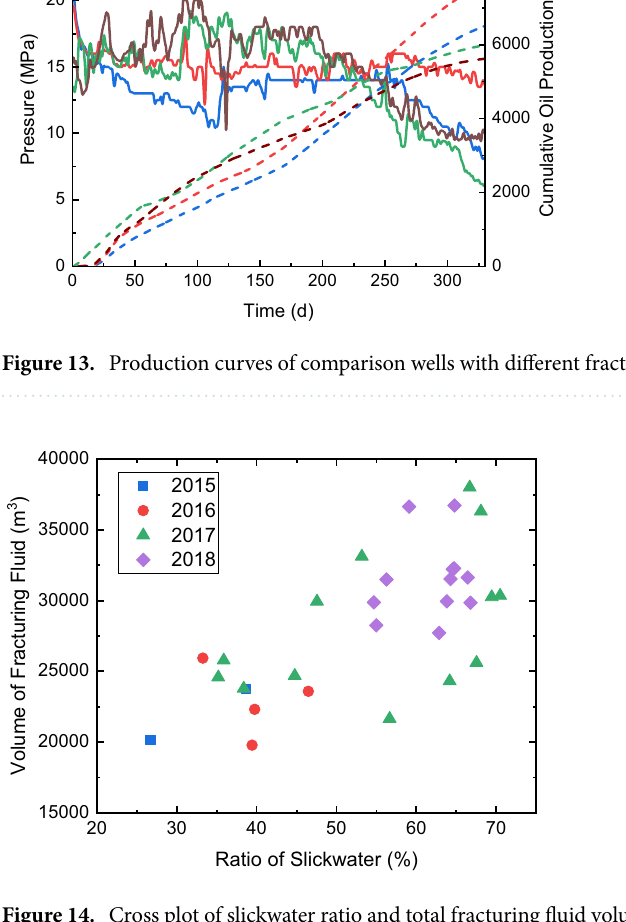
Figure 14. Cross plot of slickwater ratio and total fracturing fluid volume of experimental wells in 4